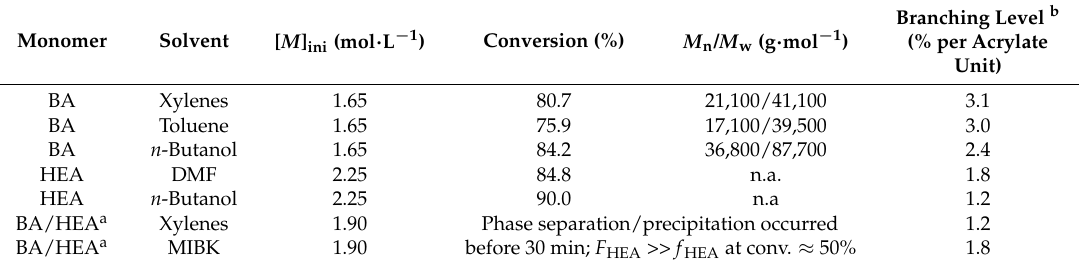
Table 2. Final monomer conversions, average polymer molar masses and branching levels measured